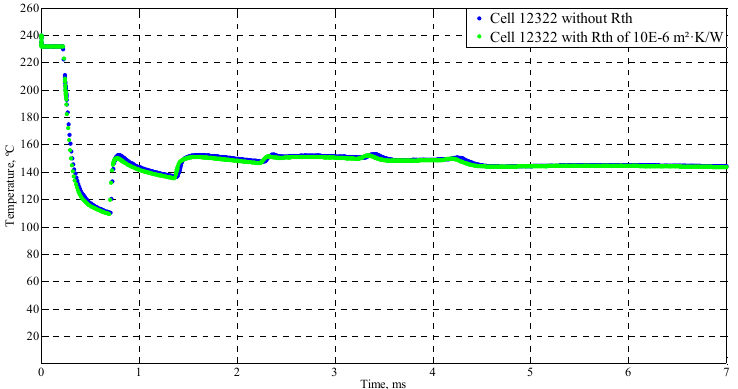
Figure 7. Temperature evolution of the splat cell 12322 without R th and with R th of 10 − 6 m 2 ·K/W.